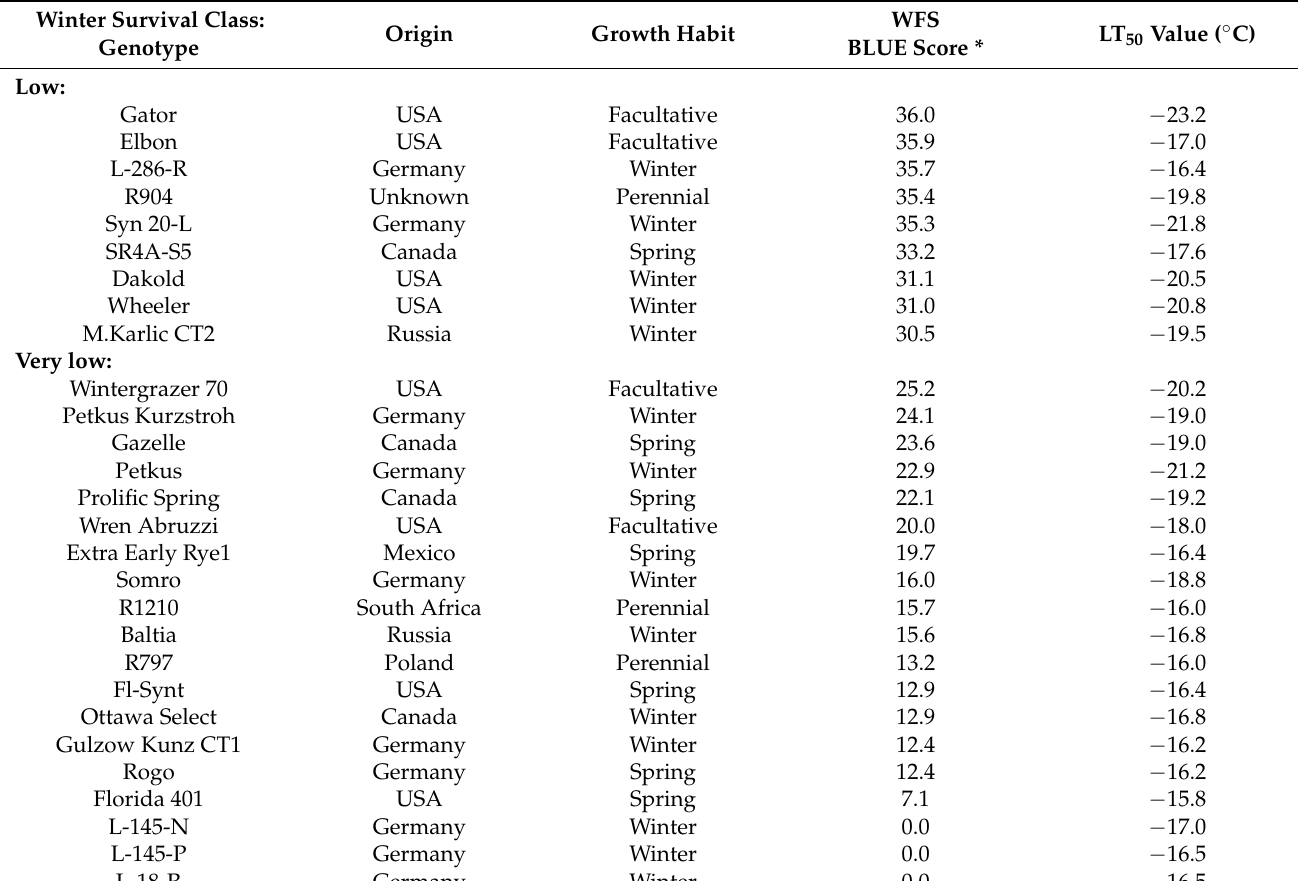
(Table 1). Eleven of the nineteen genotypes within the very high WFS class were